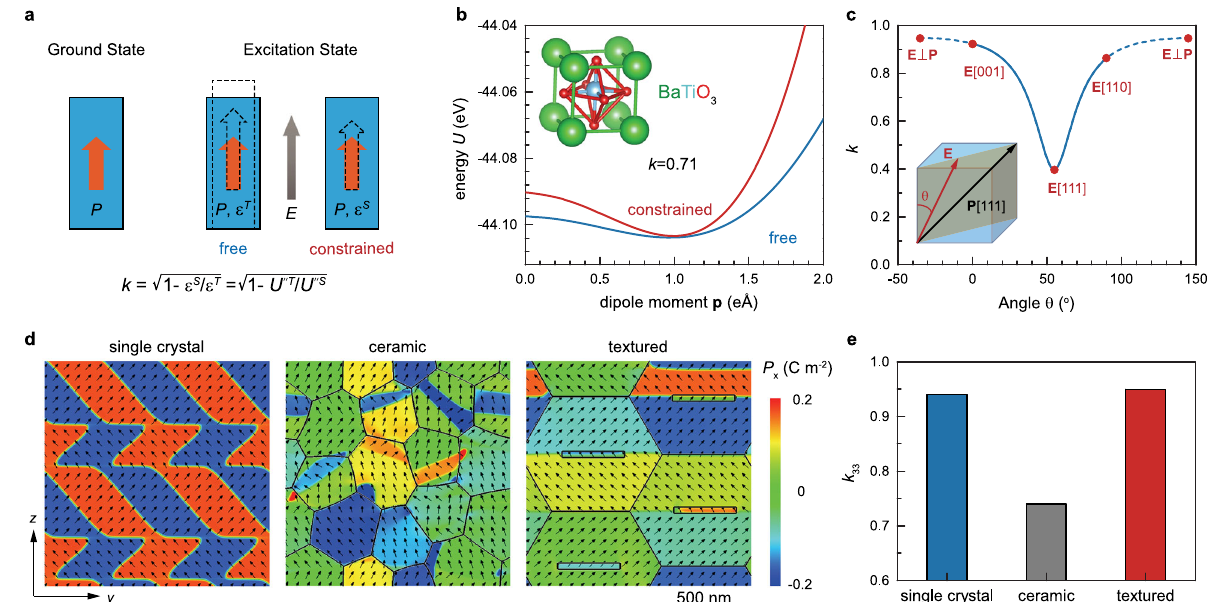
Fig. 1 Electromechanical coupling of piezoelectric materials. a De fi nition of electromechanical coupling factor, k . The parameter k characterizes the conversion between electrical energy and mechanical energy, which is related to two different excitation states of polarization in ferroelectric materials, namely, the free and the constrained. b First-principles calculated energy pro fi les of BaTiO 3 with free and constrained unit cell. c Simulated k for the rhombohedral PMN-PT single crystal under the electric fi eld with various orientations. d Domain structures, and e corresponding longitudinal electromechanical coupling factor k 33 of single crystal, random ceramic and textured ceramic after the electrical poling along [001]